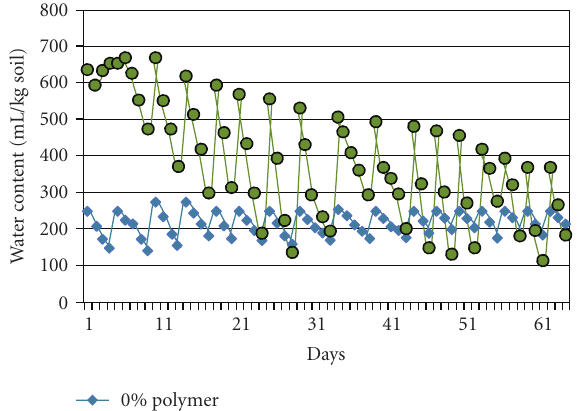
Figure 3: Changes in the water content of a mine soil without or with 0.4% polyacrylate polymers.